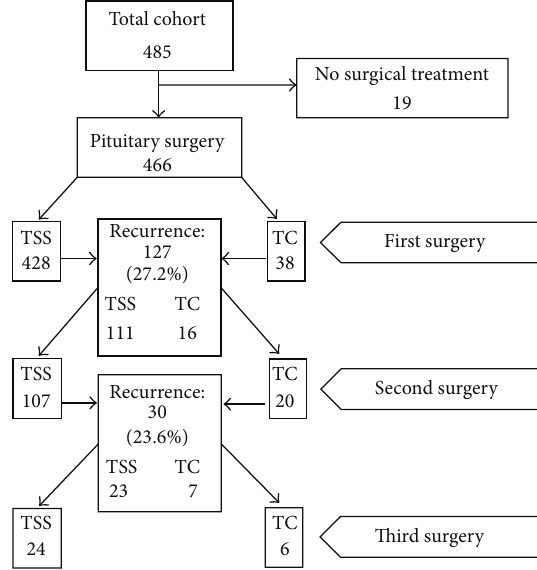
Figure 2: Number of patients undergoing one, two, and three surgical procedures and the corresponding persistence rates.